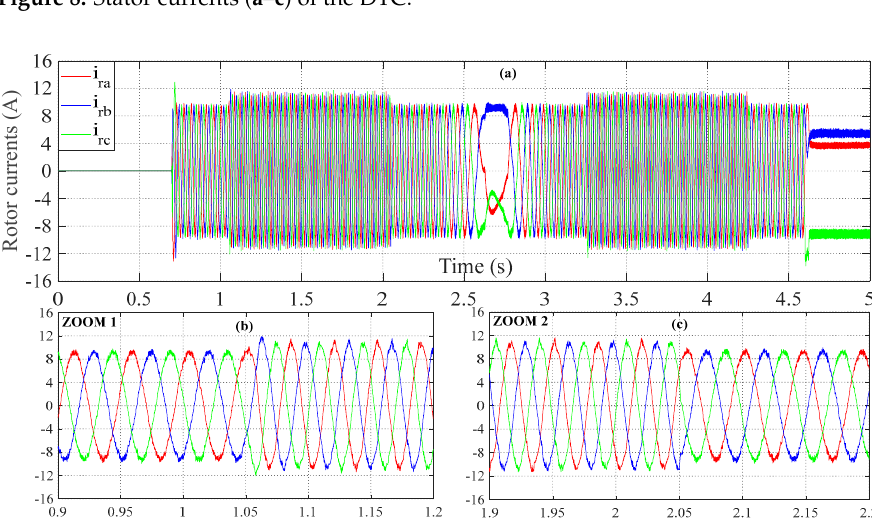
Figure 9. Rotor currents ( a – c ) of the DTC.